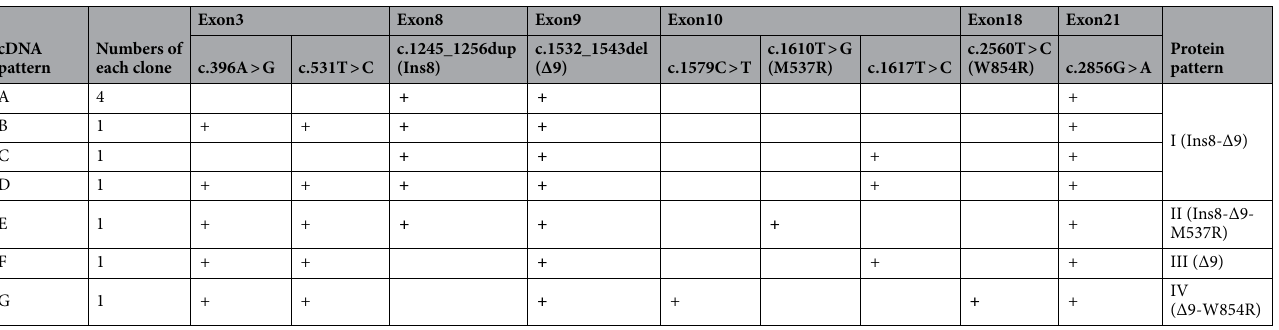
Table 1. Summary of the mutations found in cDNA analysis from the spleen of patient cat. + (plus) indicated the mutations found in cDNA clones, whereas empty columns indicated no mutation. Bold values indicated the mutations resulting in changes of amino